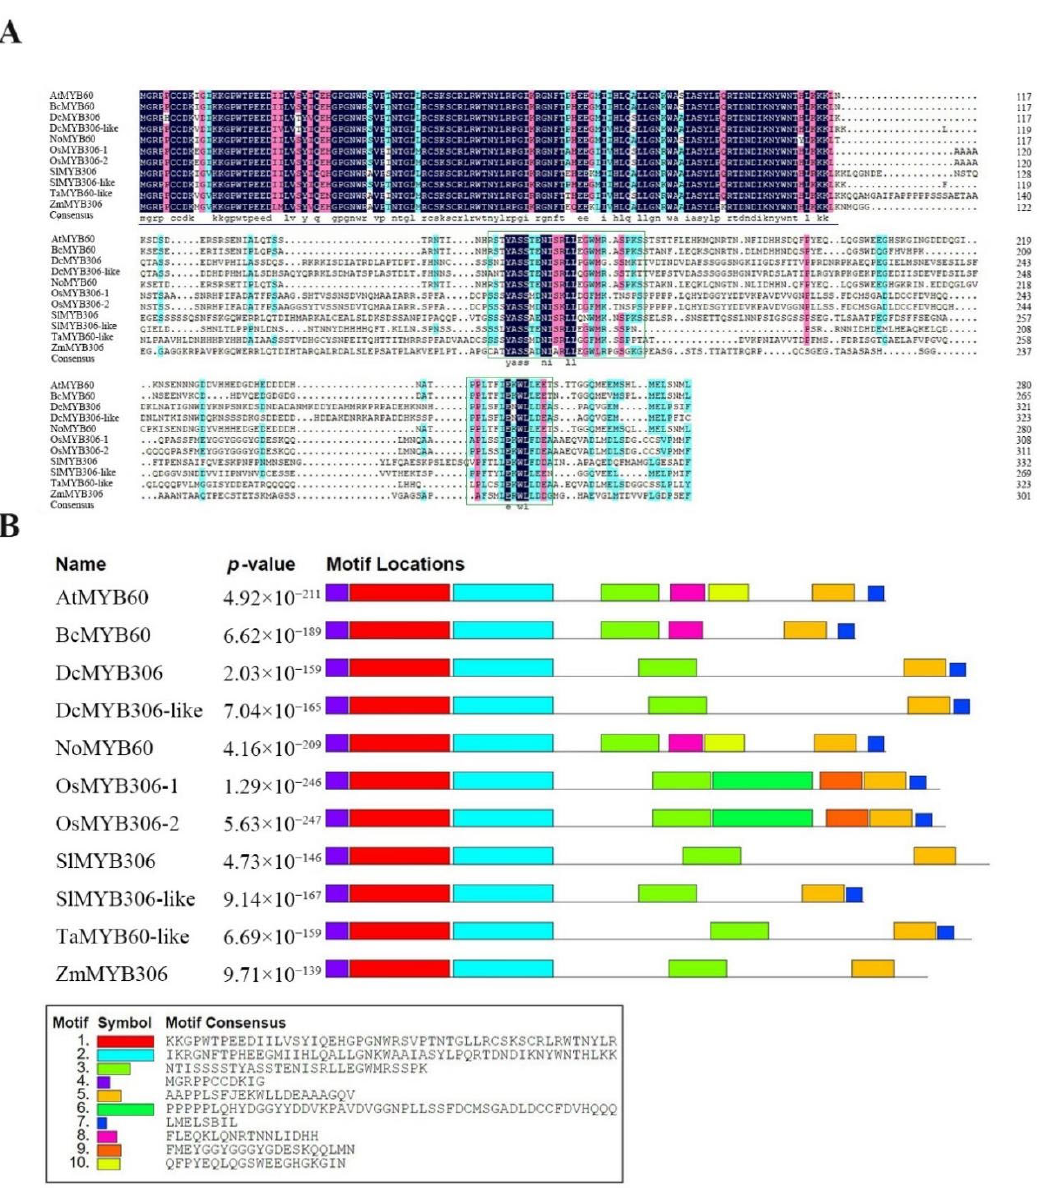
Figure 1. Multiple sequence alignment and structure analysis of MYB60 protein. ( A ) Multiple sequence alignment of MYB60 protein in different species, including Arabidopsis (At), pak choi (Bc), N. officinale (No), O. sativa (Os), Z. mays (Zm), S. lycopersicum (Sl), D. carota (Dc) and T. aestivum (Ta). The conserved R2R3 domain sequence is marked above the purple line and the conserved Box1 and Box2 sequences are marked in the green box. ( B ) MYB60 protein has a conservative motif distribution, and the related sequence information of ten motifs is at the bottom of the picture.